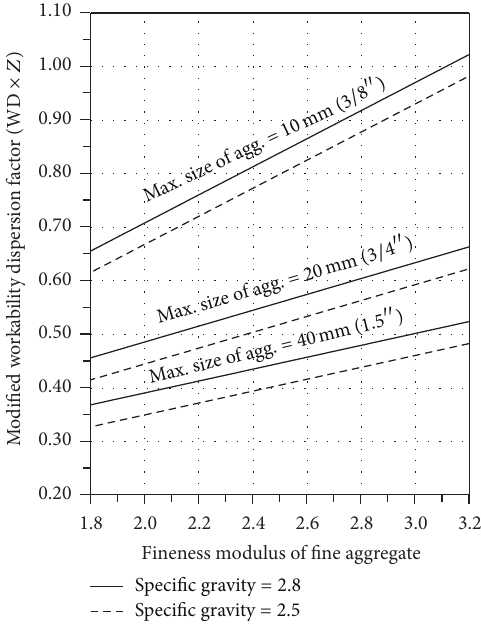
Figure 2: Relationship between fineness modulus of fine aggregate and the workability-dispersion